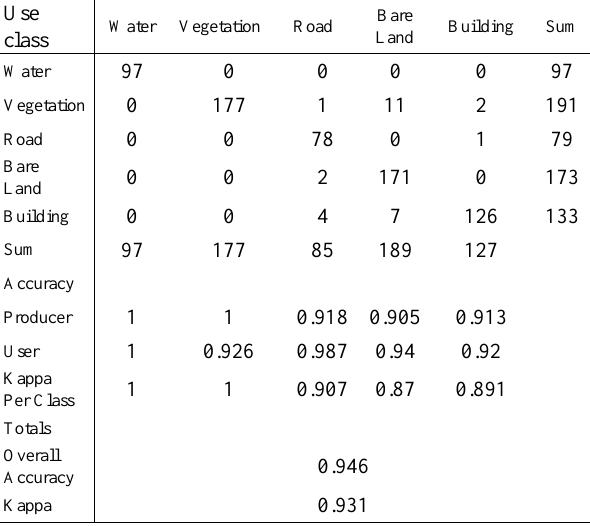
Table 2. Accuracy